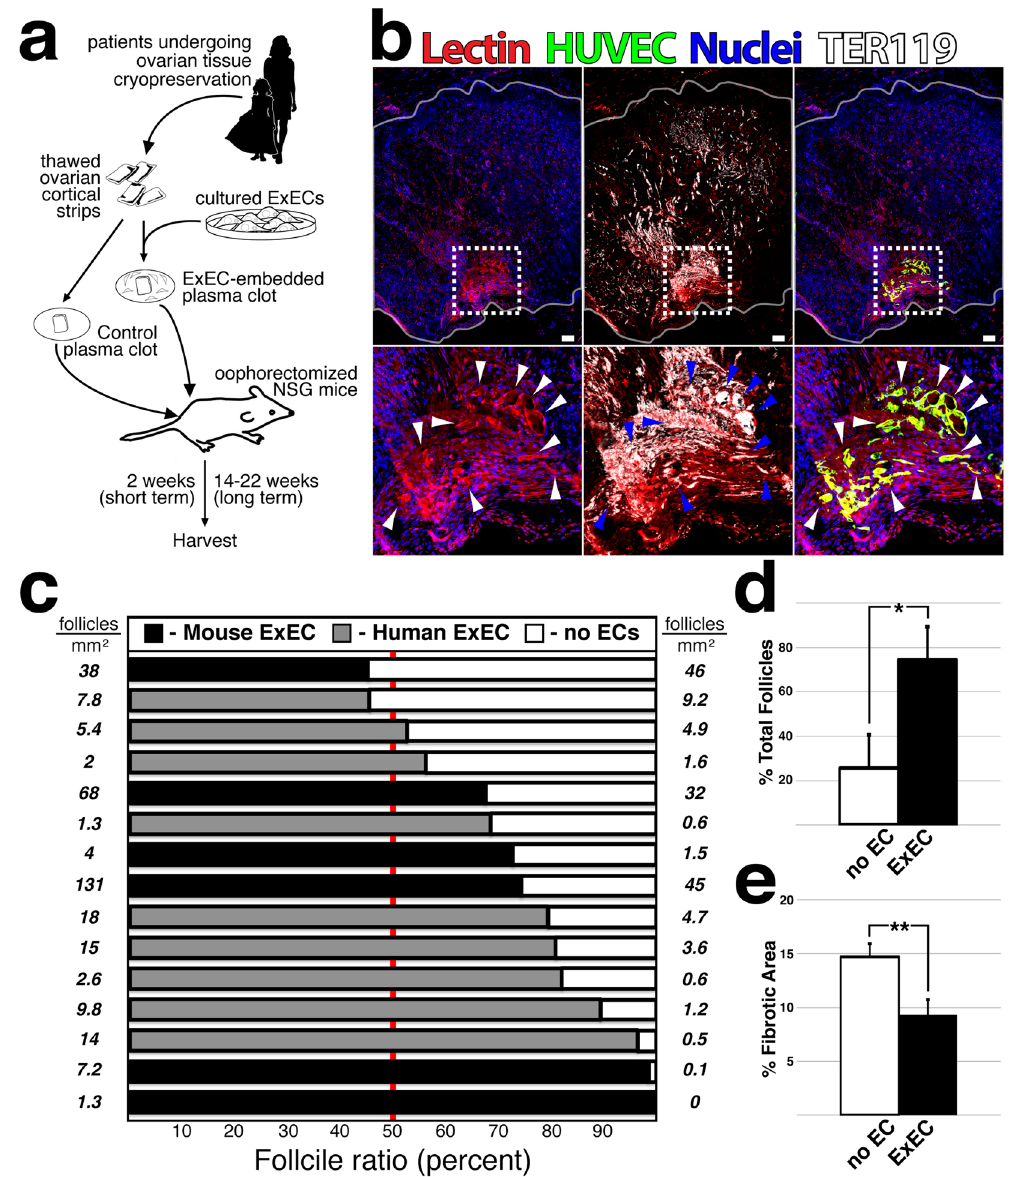
Figure 2. Co-transplantation of ovarian cortical strips with ExECs improves viability and preserves the follicular pool. ( a ) Scheme of the experimental design. Frozen-thawed human ovarian tissue was encapsulated in a plasma clot, with or without endothelial cells; ExEC-embedded plasma clot, Control plasma clot, respectively. The clots were transplanted into oophorectomized NSG mice and harvested at the end point of the experiment. ( b ) Human cortical grafts co-transplanted with hUVEC-derived ExECs (green); red blood cells are labeled by TER-119 and boundaries of the graft are outlined in white. ( c ) The ratio of surviving normal follicles in human ovarian tissue xenografted with and without the mouse or human ExECs in comparison to no cells. Each row represents a replicate originating from the same patient transplanted into the same mouse, serving as its own control. On each side of the graph, the density of the follicles per millimeter squared is indicated. ( d ) Median percentage of total follicles from transplantation with and without mouse or human ExECs + MAD. * P < 0.05. ( e ) Median percentage of the fibrotic area from transplantation with and without mouse or human ExECs + MAD. ** P <